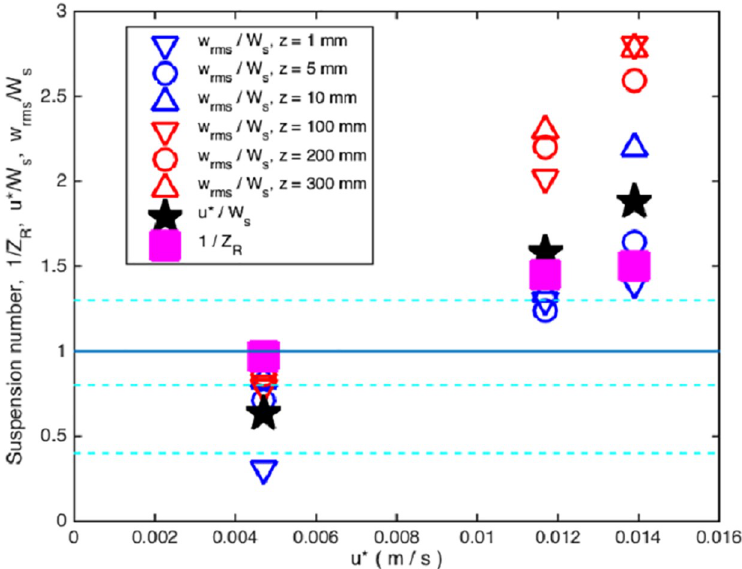
Fig 4. Suspension parameter 1 transport criteria. Dashed lines mark delimiting values of the inverse of the Rouse number for bed load ( 1/Z R < 0.4), approximately 50% of suspended sediment (0.4 < 1/Z < 1.3), and wash load ( 1/Z R >